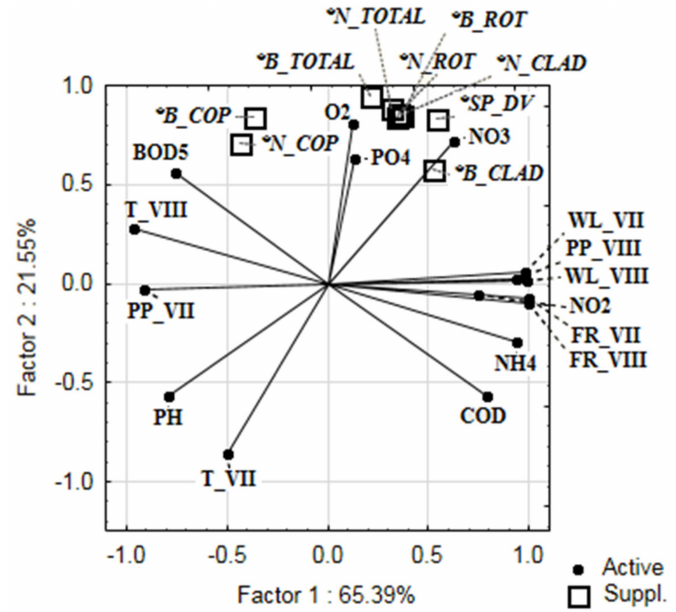
Figure 7. Biplot of Principal component analysis of zooplankton groups (number of Rotifera N_ROT, number of Cladocera N_CLAD, number of Copepoda N_COP, total number of zooplankton N_TOTAL, biomass of Rotifera B_ROT, biomass of Cladocera B_CLAD, biomass of Copepoda B_COP, total biomass of zooplankton B_TOTAL, quantity of species SP_DV) and environmental variables in- cluding precipitation in July (PP–VII), precipitation in August (PP–VIII), temperature in July (T–VII), temperature in August (T–VIII), flow rate in July (RF–VII), flow rate in August (FR–VIII), water level in July (WL–VII), water level in August (WL–VIII), phosphate (PO 43 − ), ammonia nitrogen (NH 4+ -N), nitrite (NO 2 − - -N), nitrate (NO 3 − -N), dissolved oxygen (O 2 ), pH, chemical oxygen demand-(COD) and biochemical oxygen demand (BOD 5 ) in the Ob River. Table 4. Mean, standard deviation and correlation coefficients ( p -value < 0.05) between physical-chemical parameters and zooplankton abundance of Ob River in the long-term observations (1994–2009). Means ± St.Dev. Copepoda Cladocera Rotifera Total Zooplankton 110.28 ±